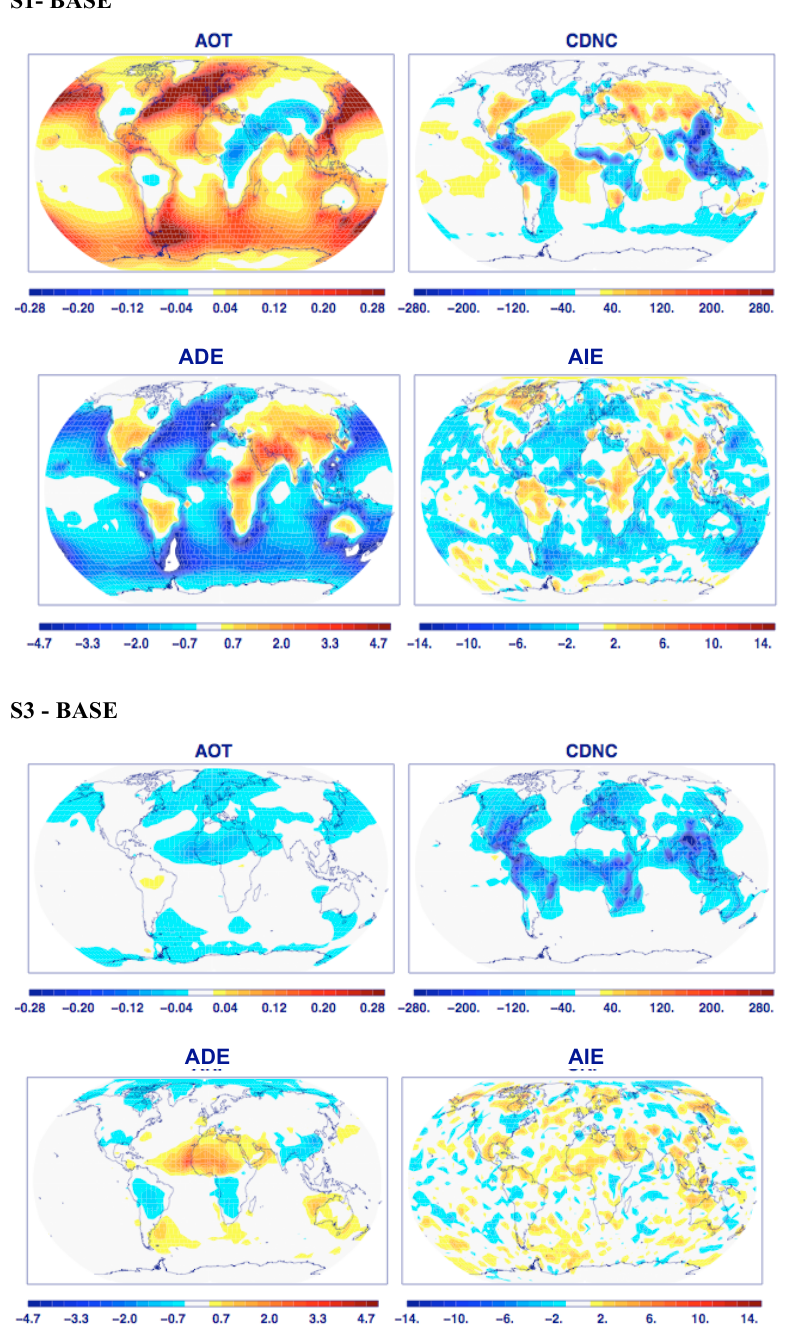
Figure 3 Changes between BASE and S1 (S1-BASE) (upper panels) and (S3 - BASE) (lower panels) for AOT, CDNC [#/cm 3 ], ADE [W/m 2 ] and AIE [W/m 2 ]. All maps show differences between the experiments for present day conditions.